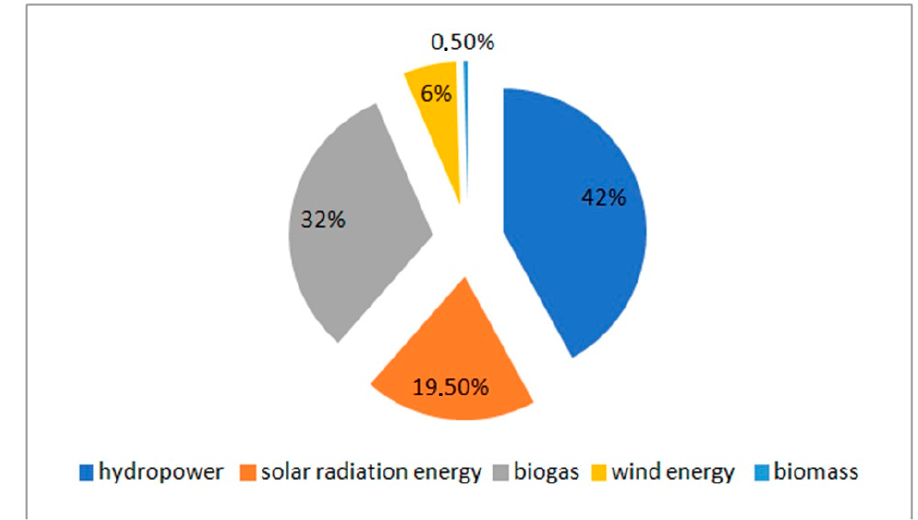
Figure 18. Share of energy sources in total production in 2020 [64].